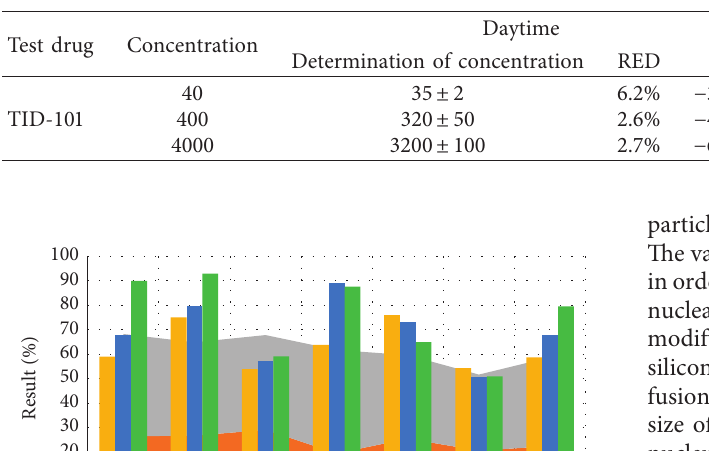
Figure 1: Muscle healing in different groups. Table 2: Drug concentration at different times.